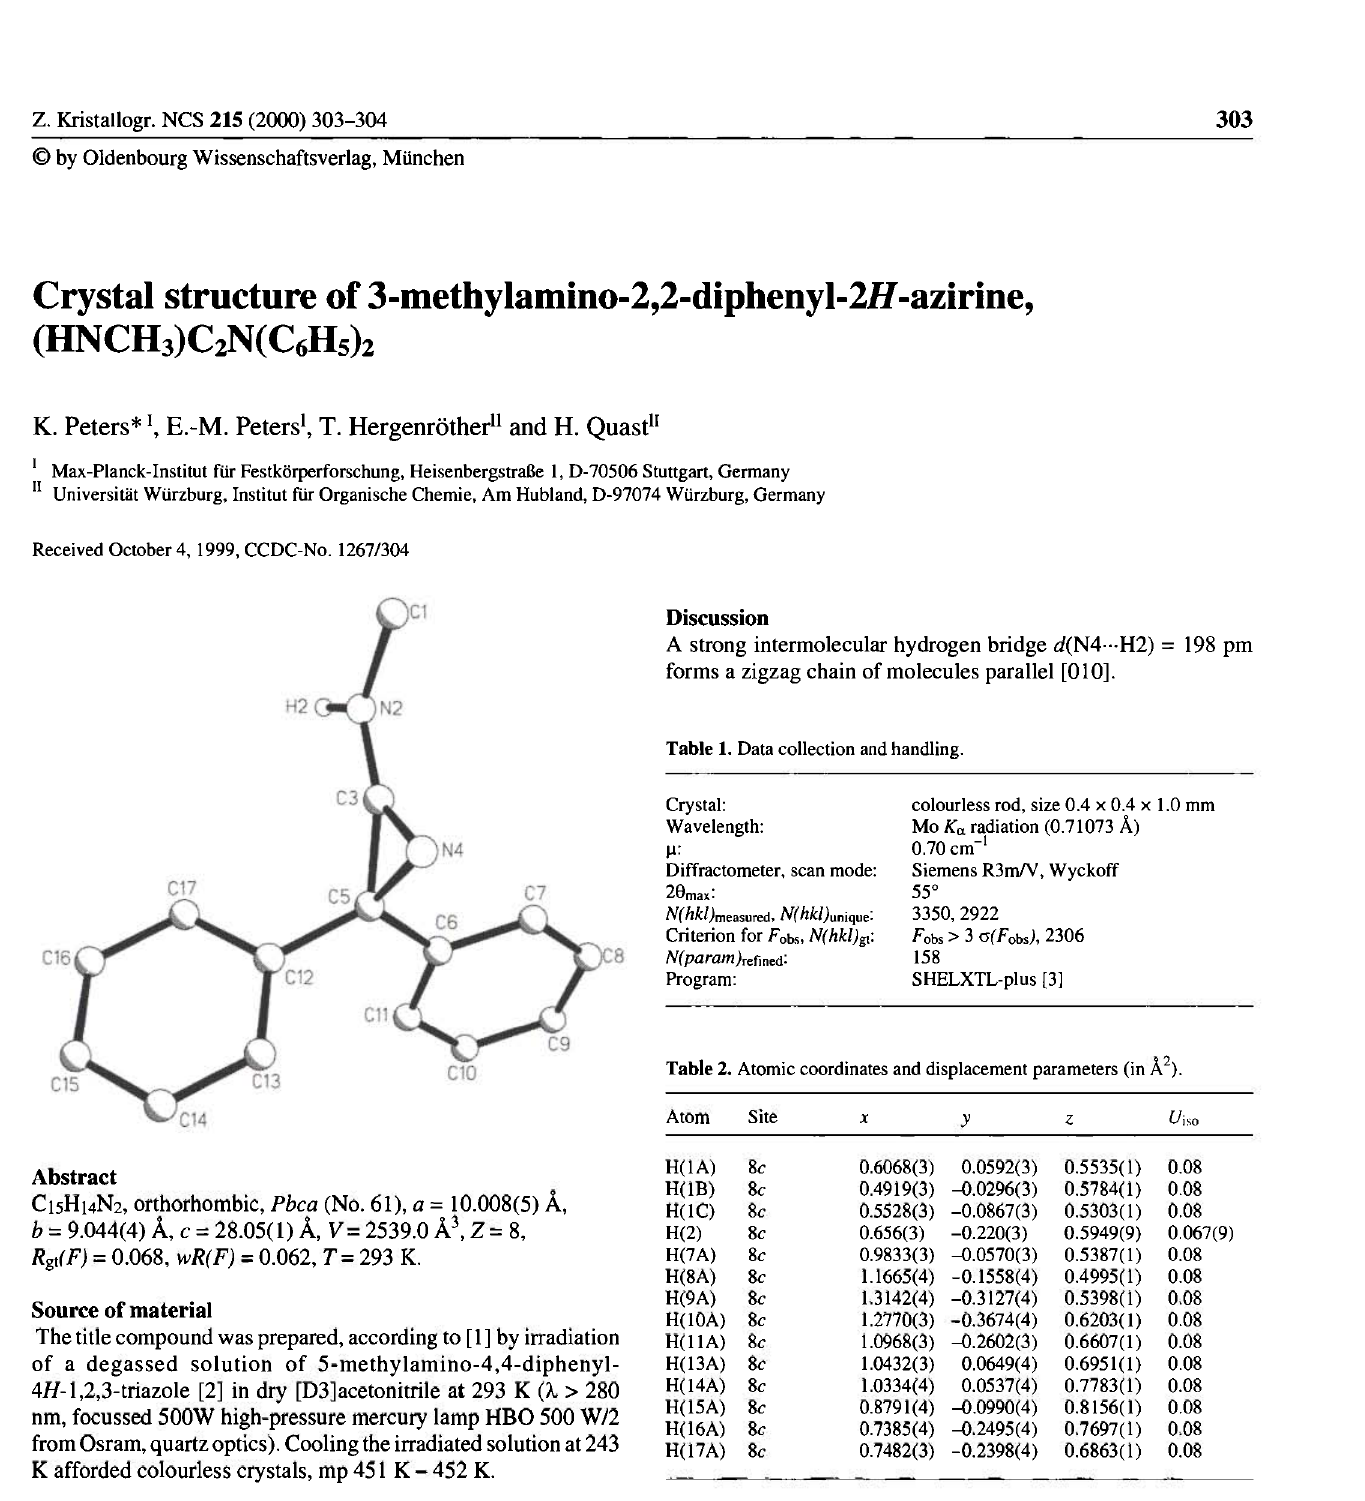
Table 3. Atomic coordinates and displacement parameters (in Ä 2